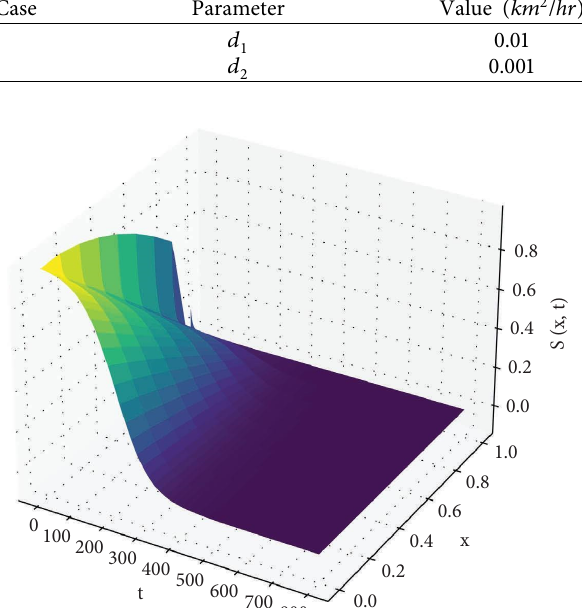
Figure 2: A 3-dimensional plot for the proportion of susceptible in space and time.